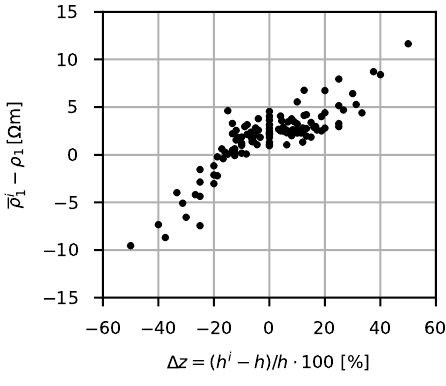
Figure 4. Absolute difference in resistivity between model and inversion result with respect to the difference between layer boundary and structural constraint relative to the thickness of the upper